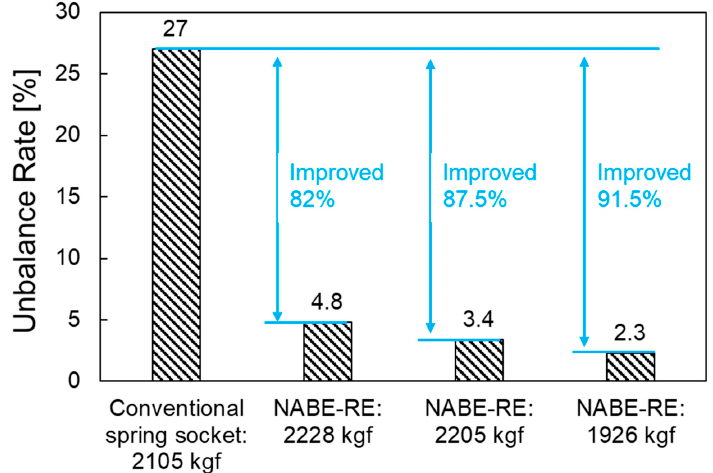
Figure 15. Results comparison of the unbalance rate under different conditions.